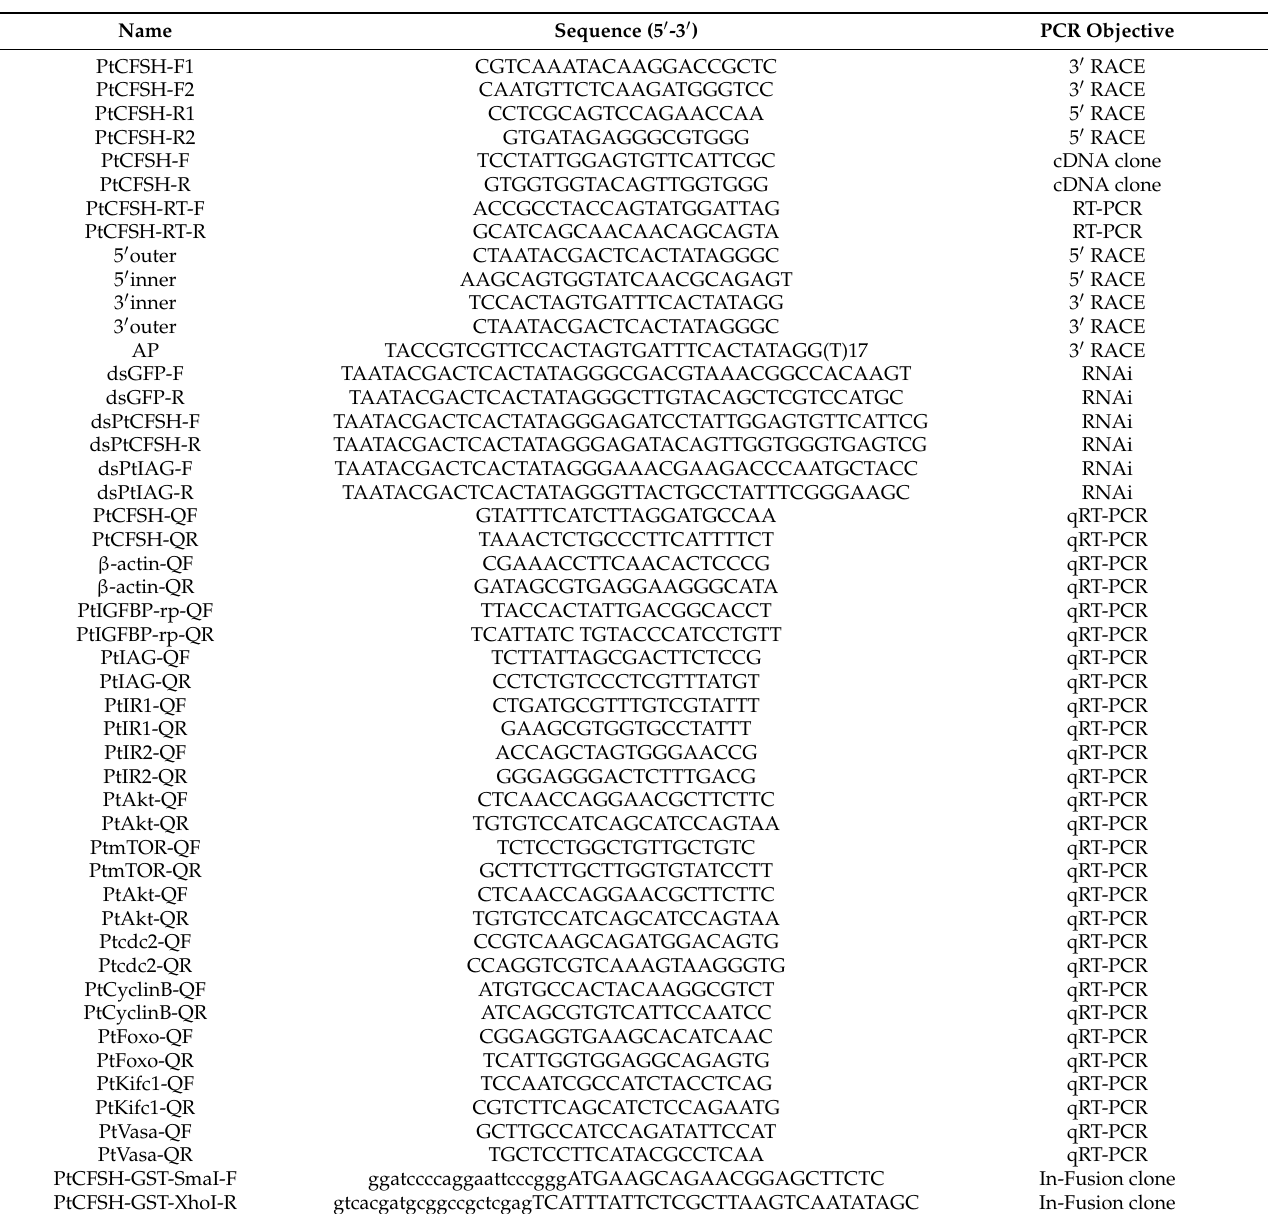
Table 1. Primers used in this